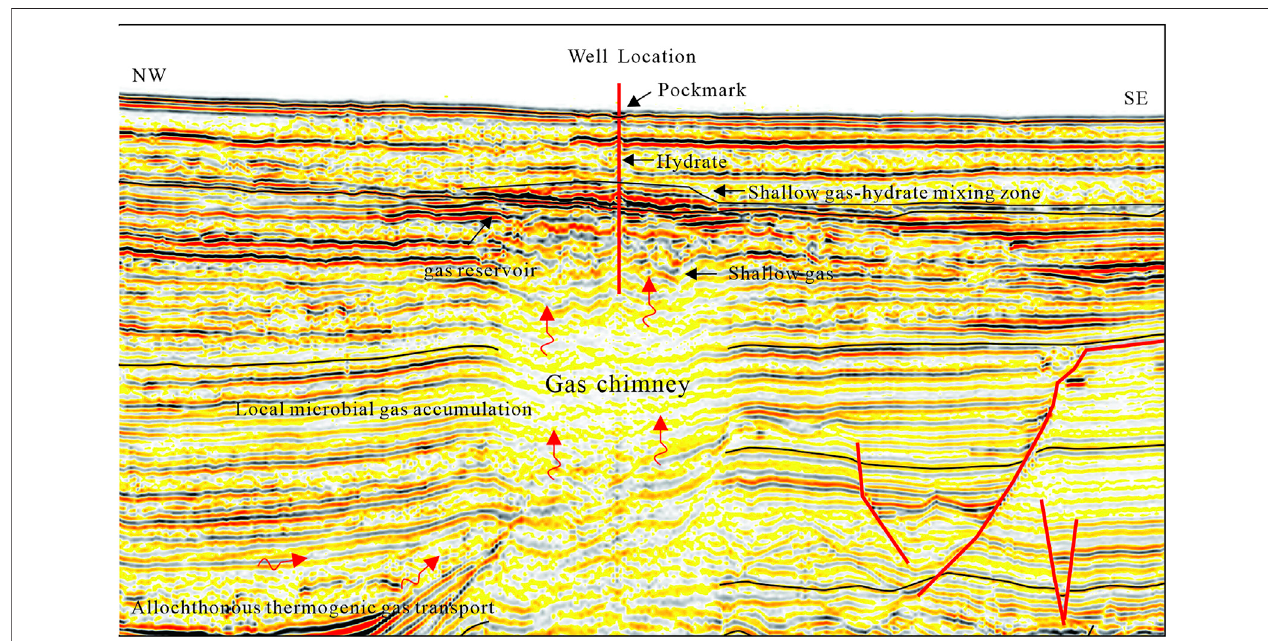
FIGURE 8 | Gas hydrate accumulation model in H area, Qiongdongnan